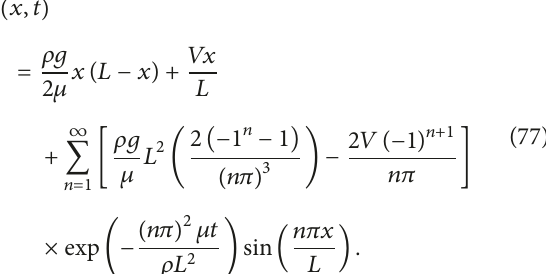
viscosity are 𝜌 = 1000 kg / m 3 and 𝜇 = 10 −3 Pa ⋅ s,